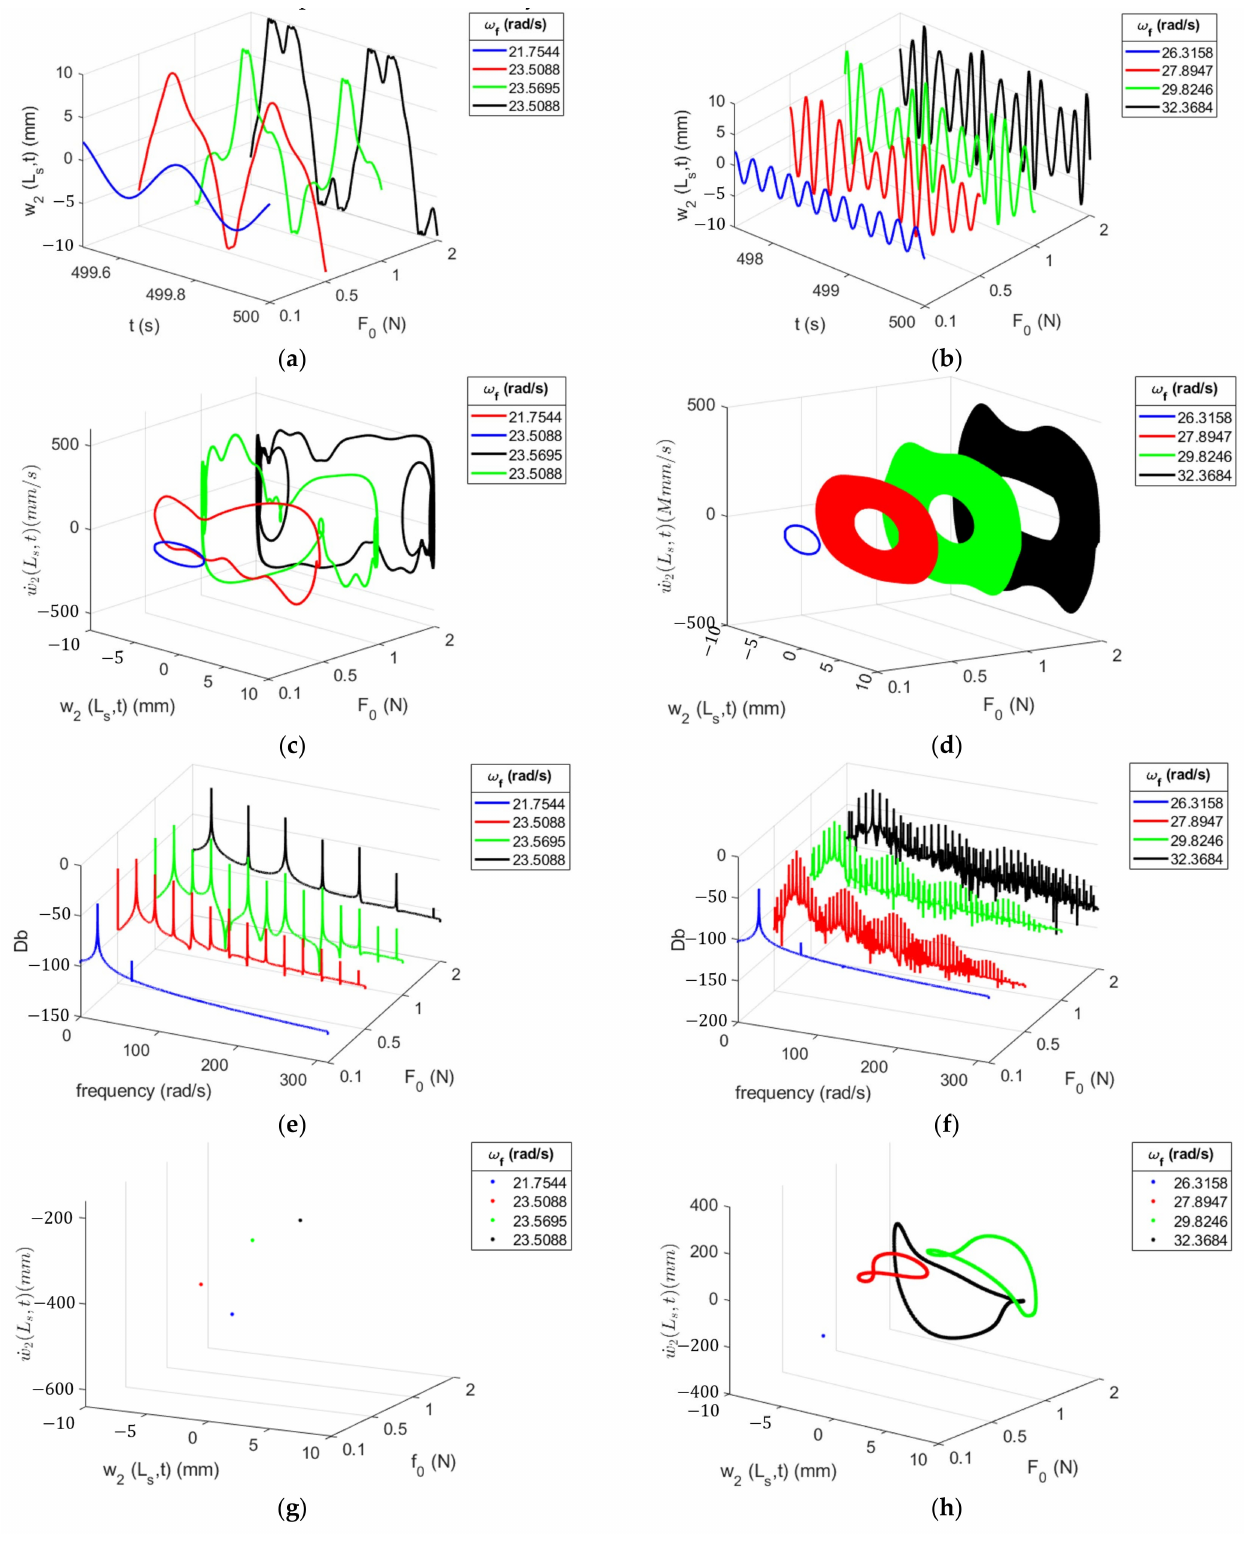
Figure 34. Nonlinear characterization of the absorber’s first (first column) and second peaks (sec- ond column) utilizing time histories ( a , b ), phase portraits ( c , d ), power spectra ( e , f ) and Poincare maps ( g , h